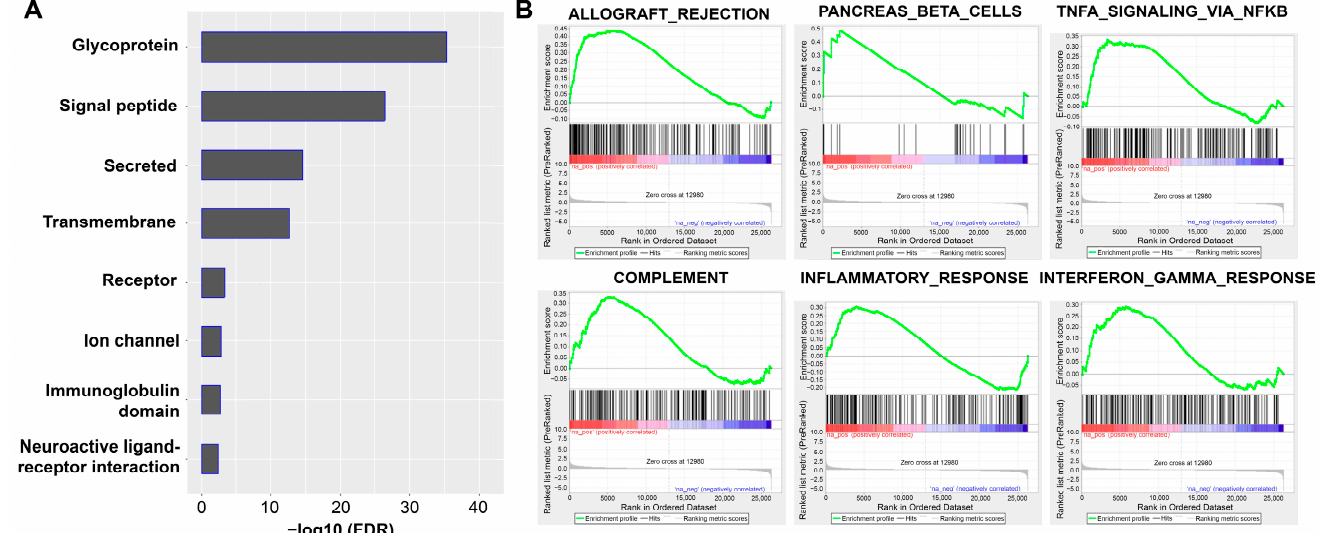
Figure 4. Enrichment analysis of differentially expressed genes in VS stratified by the presence or absence of tinnitus. ( A ) Functional enrichment analysis of differentially expressed genes by using DAVID revealed functional gene categories. ( B ) All genes ranked according to the magnitude of expression change (fold change) between VS patients with and without tinnitus were analyzed for the enrichment of functional gene categories by using GSEA. Five of the six top GSEAs were associated with inflammation. The green line indicates the enrichment score. Red indicates positive correlation and blue indicates negative correlation in the ranked ordered dataset. Table 1. Functional pathways enriched in VS tumor tissue from patients with tinnitus compared with those without tinnitus according to